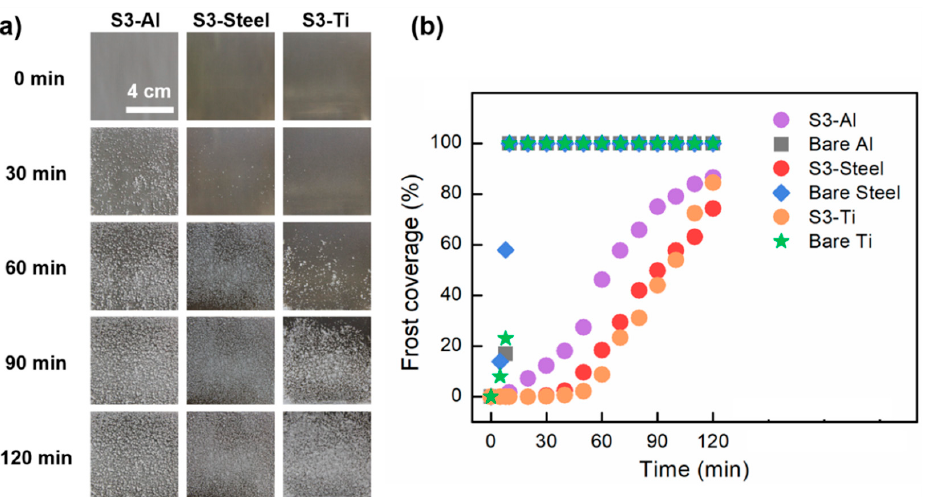
Figure 7. Frost test ( a ) and frost coverage ( b ) with respect to time for S3-Al, S3-steel, and S3-Ti surfaces and their respective bare counterparts.